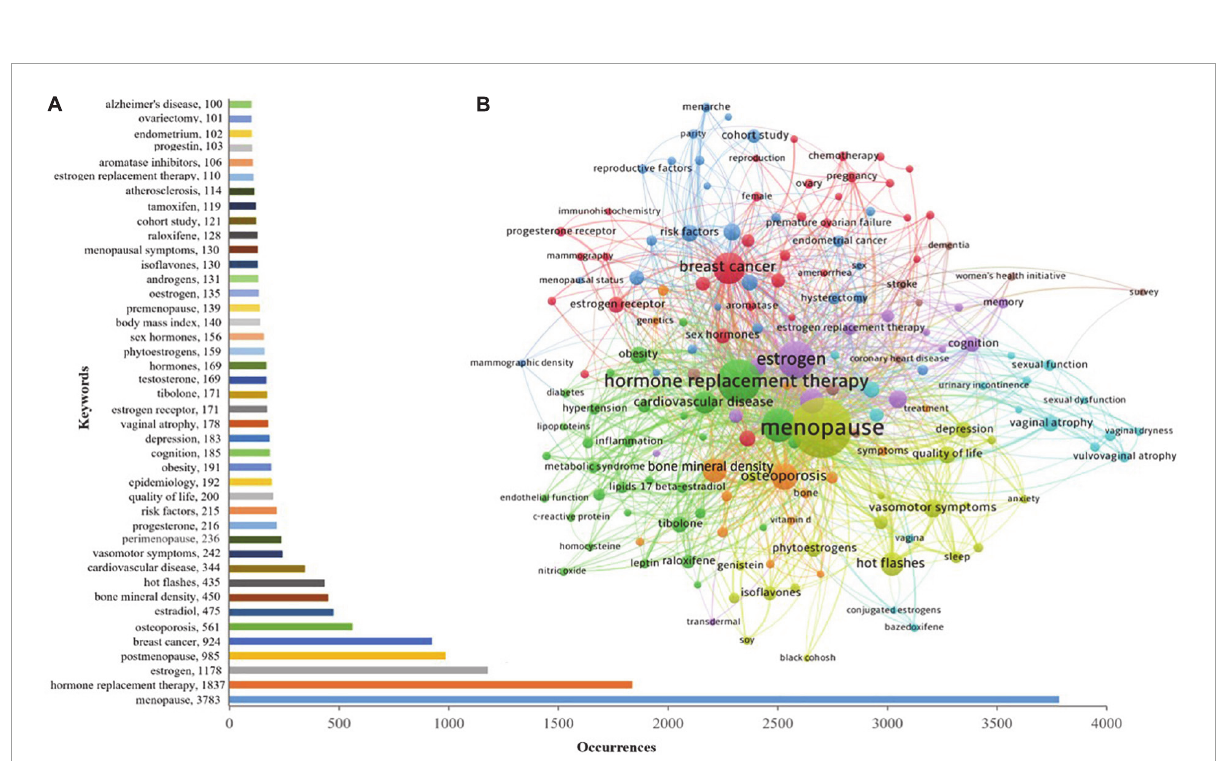
FIGURE8 (A) The keywords of number of occurrences more than 100. (B) The network map of keyword clustering showed 165 keywords with a minimal occurrence of 30 times and classified into eight